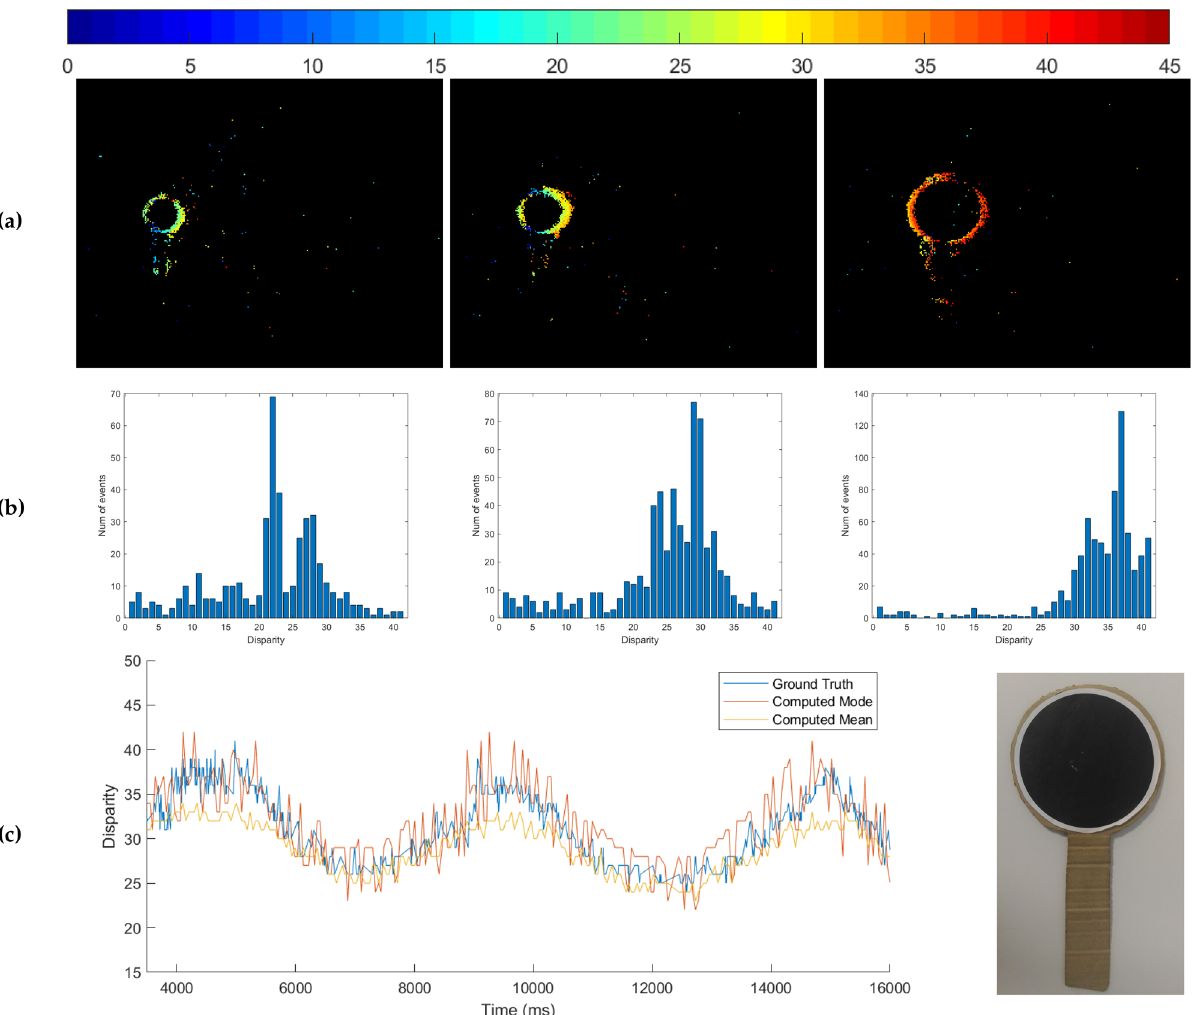
Figure 4. Evaluation of estimated disparity accuracy of a circular paddle moving to and fro along the depth axis. ( a ) Colour-coded (red = near, blue = far) event disparity maps (time window 100 ms) of the paddle at three time instances: far (left), intermediate (centre) and close (right). ( b ) The corresponding disparity distribution histograms. ( c ) Variation of ground truth and computed disparity (mean and mode within manually annotated ROI) over time, and an image of the input